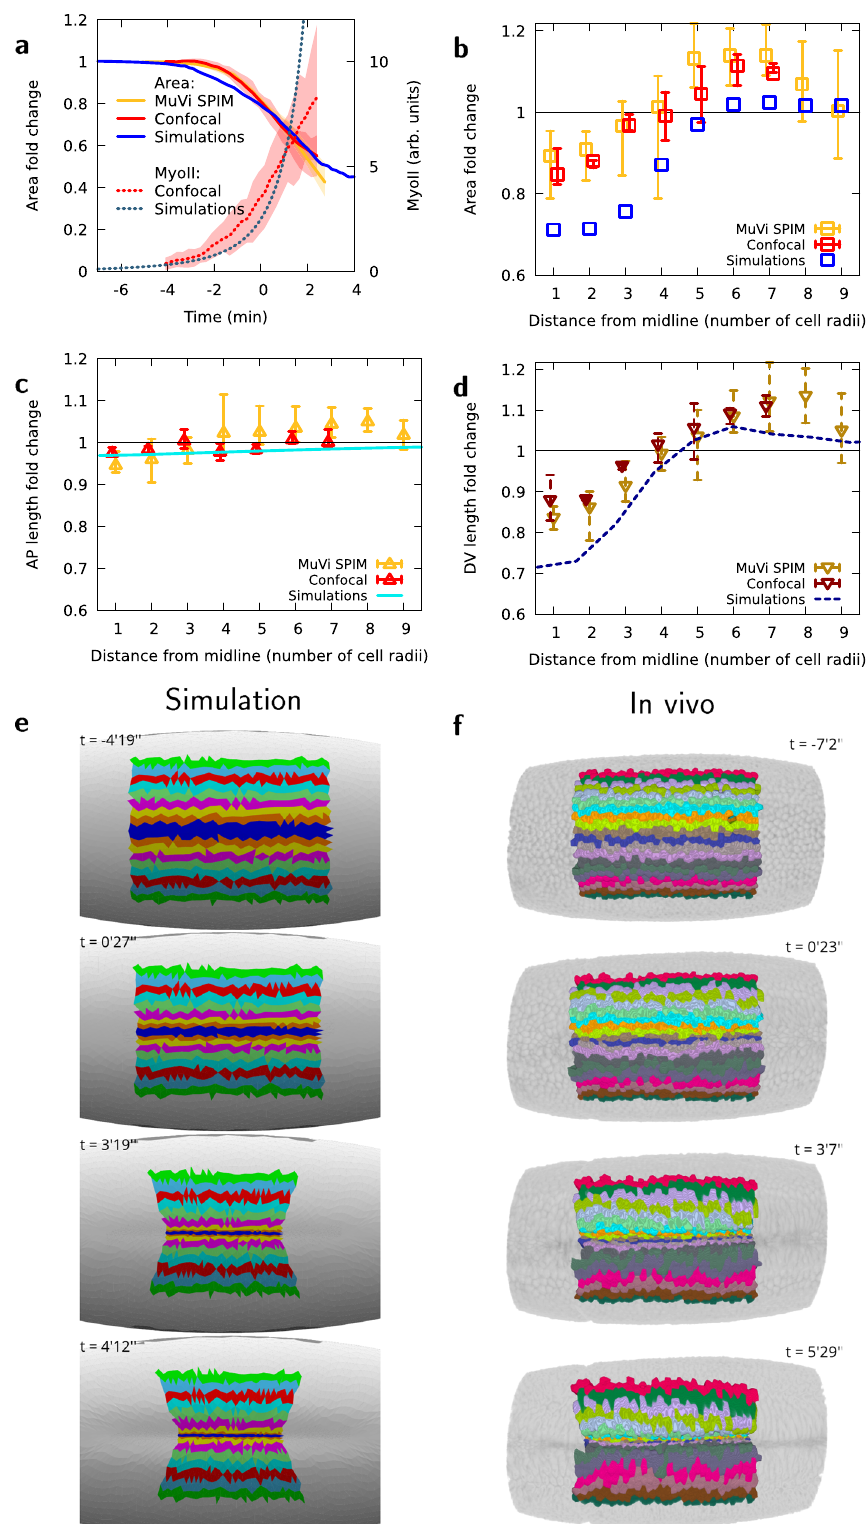
features as the computational model: the furrow forms deeper in the mid-region of the embryo and eventually propagates towards the anterior and posterior poles (Fig. 4b – d, Supplementary movie 4), even though MyoII apical accumulation and cell apical constriction are uniform along the AP axis and do not form a propagating wave (Supplementary Fig. 3b, c). The